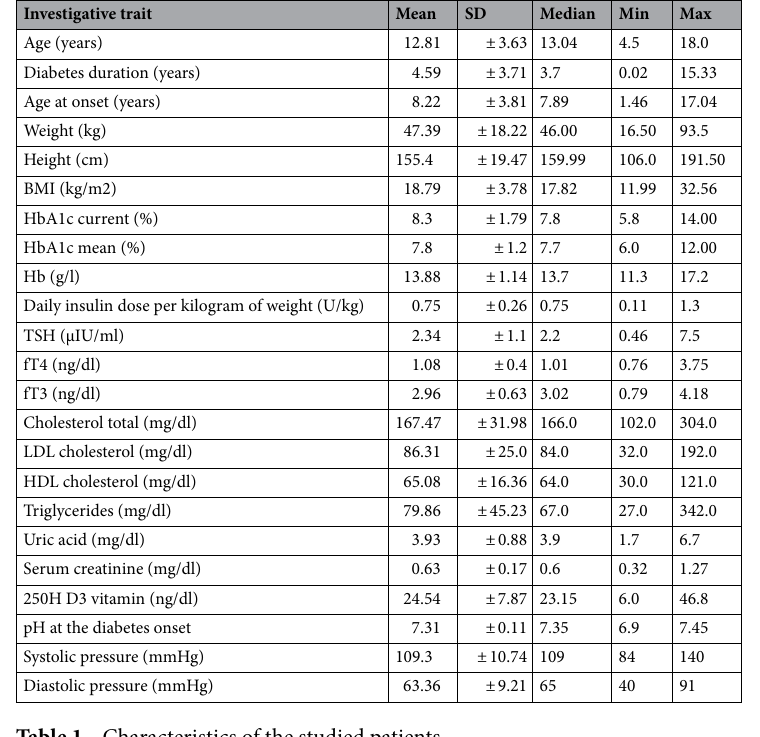
Table 1. Characteristics of the studied